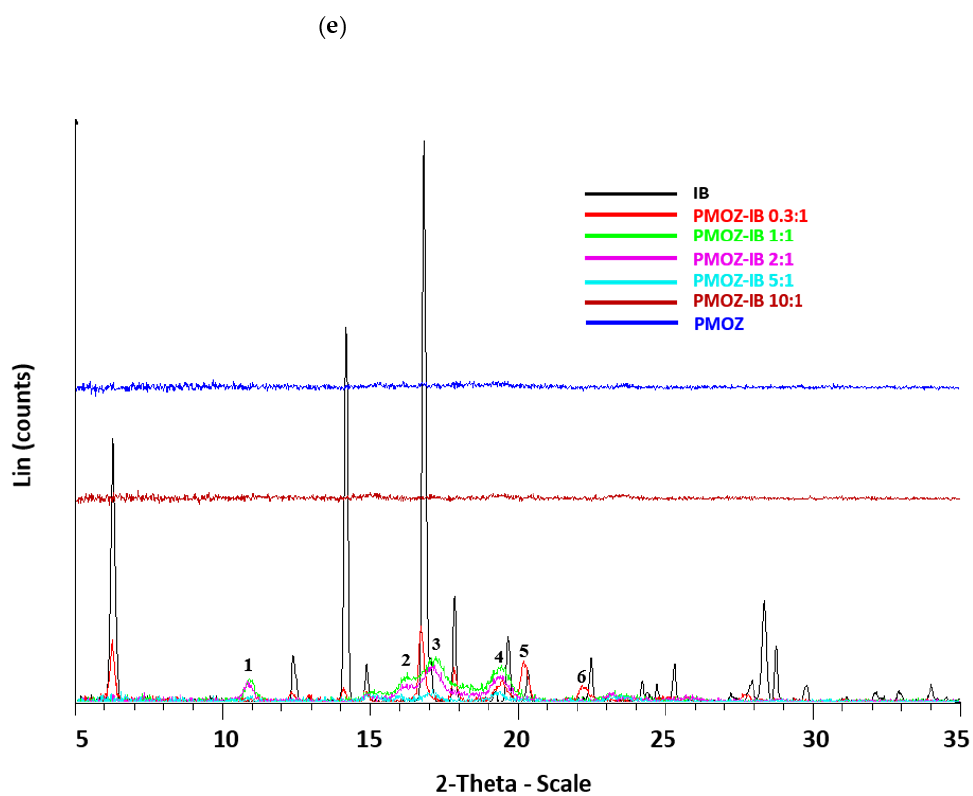
Figure 1. X-ray diffraction diagrams of PVP-IB SDs ( a ), PEOZ-IB SDs ( b ), PnPOZ-IB SDs ( c ), PiPOZ-IB SDs ( d ), and PMOZ-IB SDs ( e